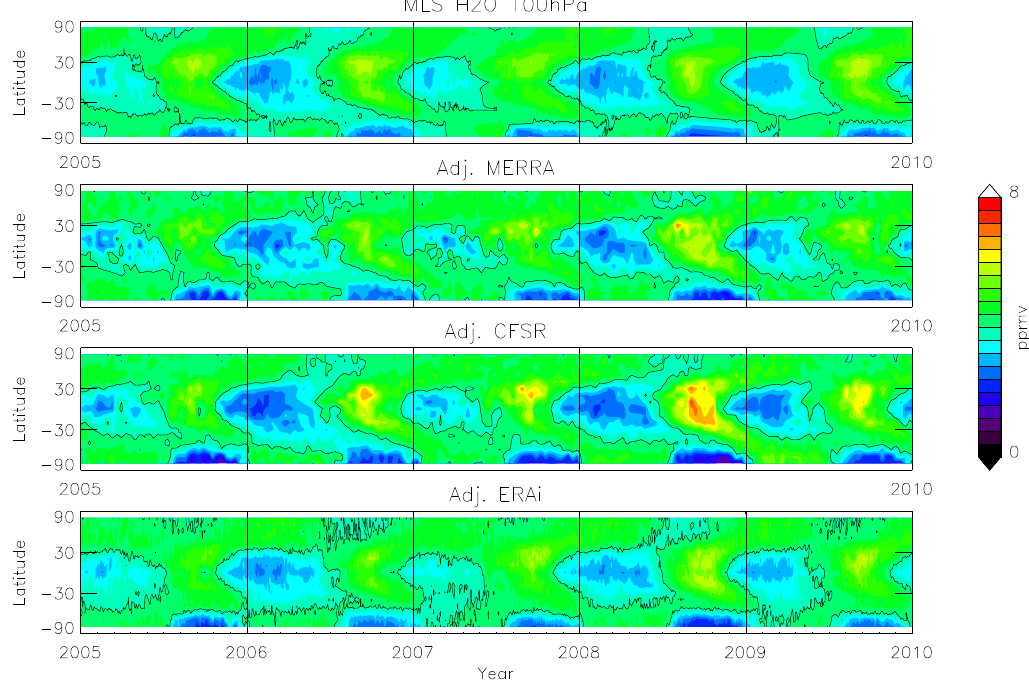
Fig. 10. Same as Fig. 9 but the water vapor fields are adjusted to the MLS zonal mean. Table 1. Average and Annual Cycle Components for Water